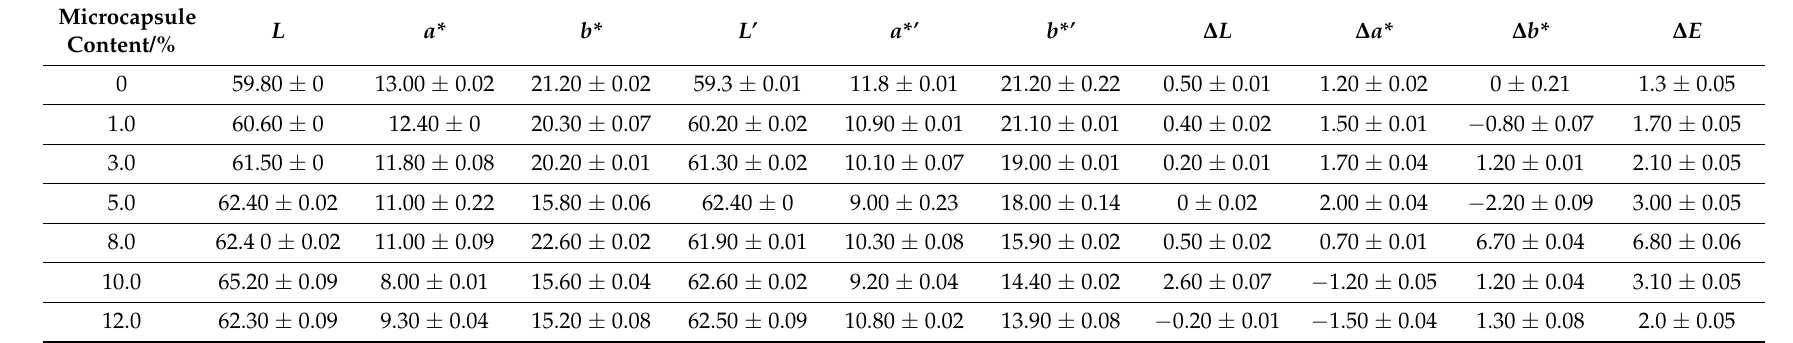
Table 2. Effect of microcapsules on color difference of waterborne